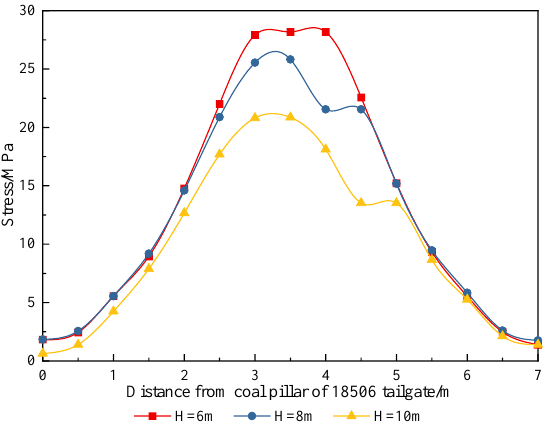
Figure 12. Vertical stress curve of surrounding rock with different top cutting heights.